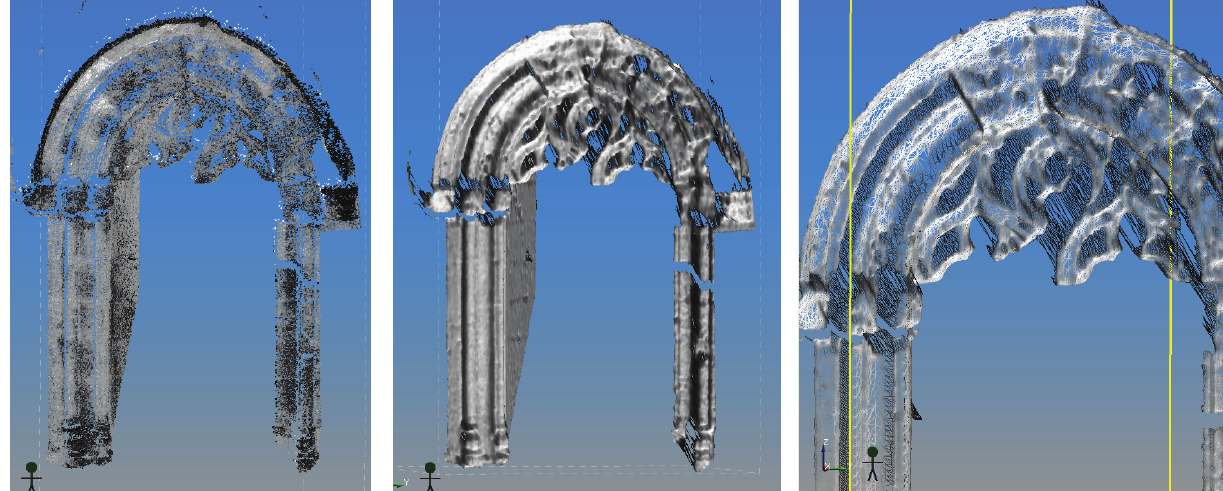
Figure 8. From the cloud point to the triangulated model of Saint Thomas’ bell tower duble mullioned